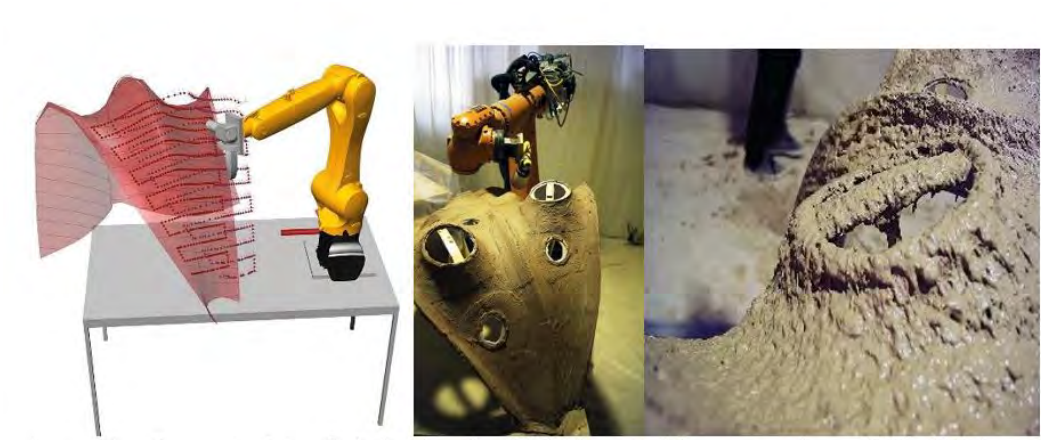
Figure 10. (a) Kuka PRC simulation of robotic trajectories after the first scan of the temporary formwork. (b) Middle layers of clay mix containing fibers applied by robotic spraying. (c) Close-up of the freshly projected fibrous clay mix robotically applied on the